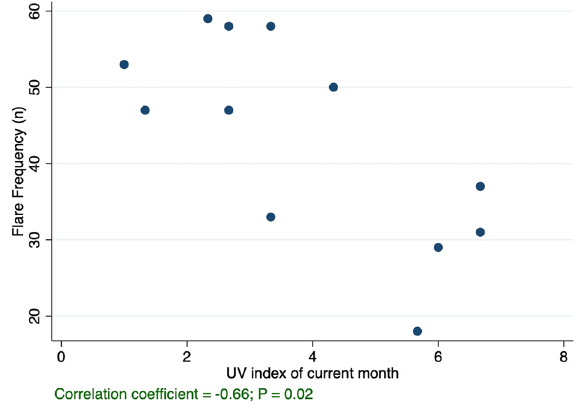
Figure 1. Scatterplot of alopecia areata (AA) flare frequency by UV index per month for children with AA in Philadelphia, Pennsylvania,